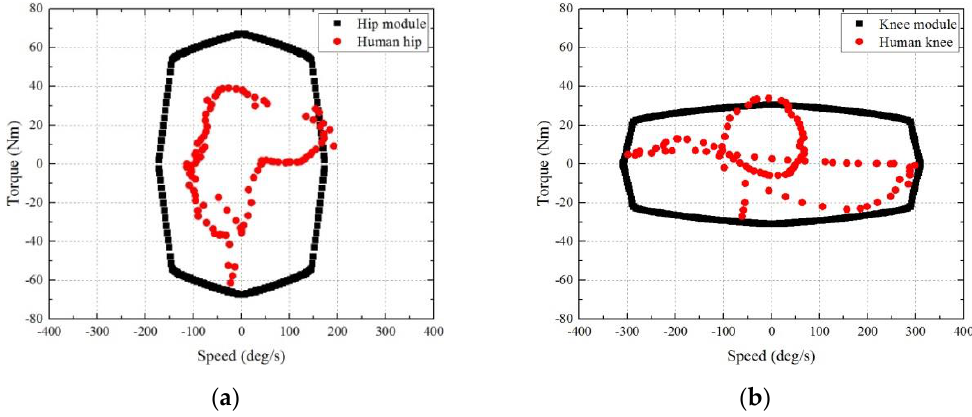
Figure 11. Comparison for ( a ) hip and ( b ) knee torque–speed characteristics of the actuation module and human joint during walking. The angular speed of each joint was calculated based on the stride time of 1.1 s.